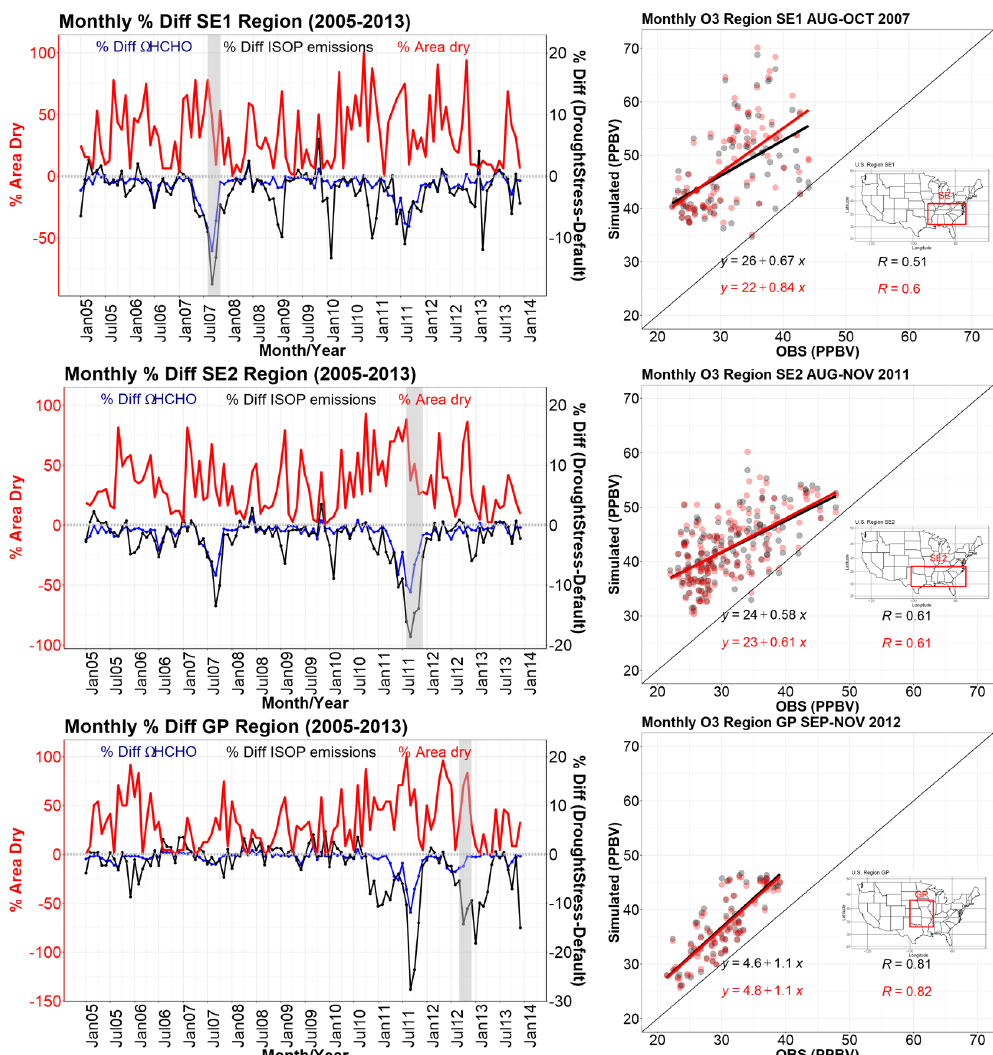
Figure 7. The time series from 2005–2013 of percent dry area on the y axis shown in red and the percent difference in (cid:127) HCHO (blue) and isoprene emissions (black) between DroughtStress_ModelE and Default_ModelE for the three regions SE1, SE2, and GP on the sec- ond y axis. Shaded in grey are the time periods of the maximum percent difference of isoprene emissions during the drought years. The scatterplots show the relationship between observed O 3 (ppbv) and simulated O 3 during the shaded grey time periods on the time series for Default_ModelE in black and DroughtStress_ModelE in red for SE1 during 2007, SE2 during 2011, and GP during 2012. Maps showing the geographic regions are inset into the scatterplots. The regions’ spatial extent is based on the region of maximum percent difference in Fig. 6c, f, and